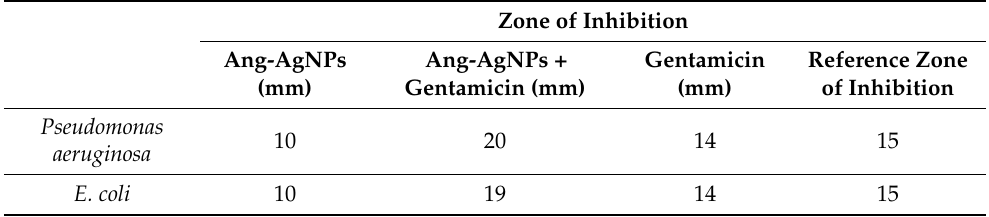
Table 1. Synergistic activity of Ans-AgNPs (4B/FM) and gentamicin against the bacterial